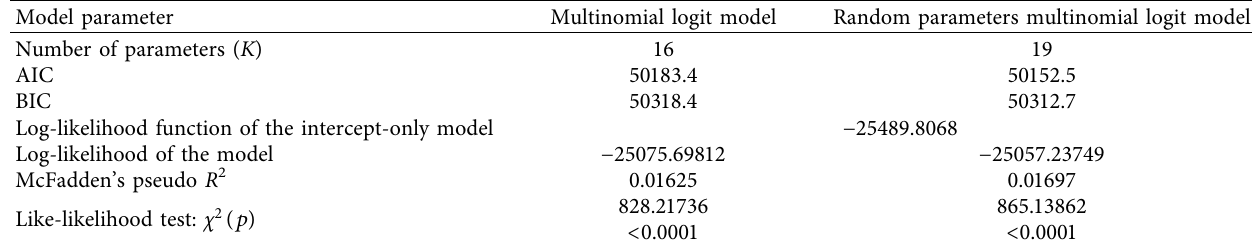
Table 3: Model performances for multinomial logit models ( N � 34,019).